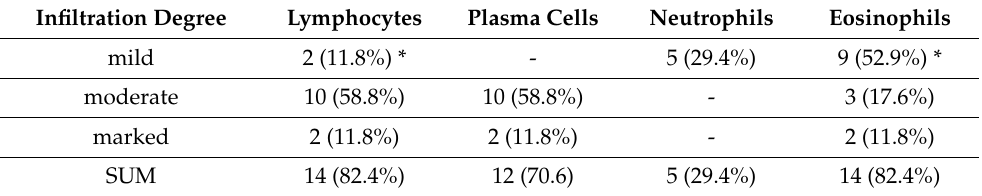
Table 4. Table showing the type of cellular infiltration in the submucosa of the rectum, along with its degree number of horses ( n = 17) and % distribution in the studied horse